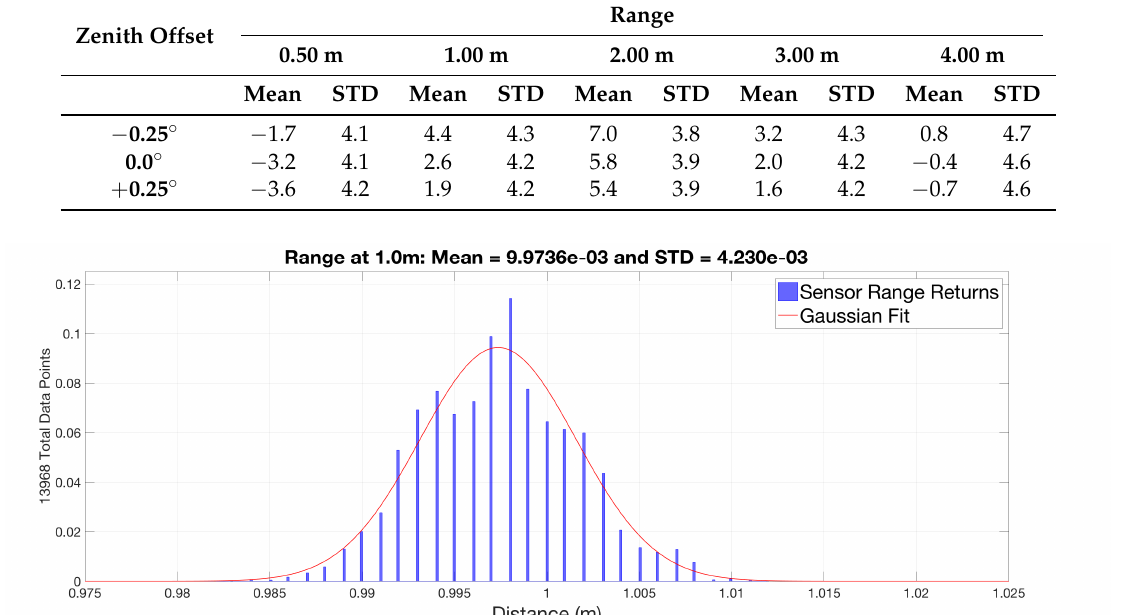
Figure 5. Example range return compared to the true range (meters) in a